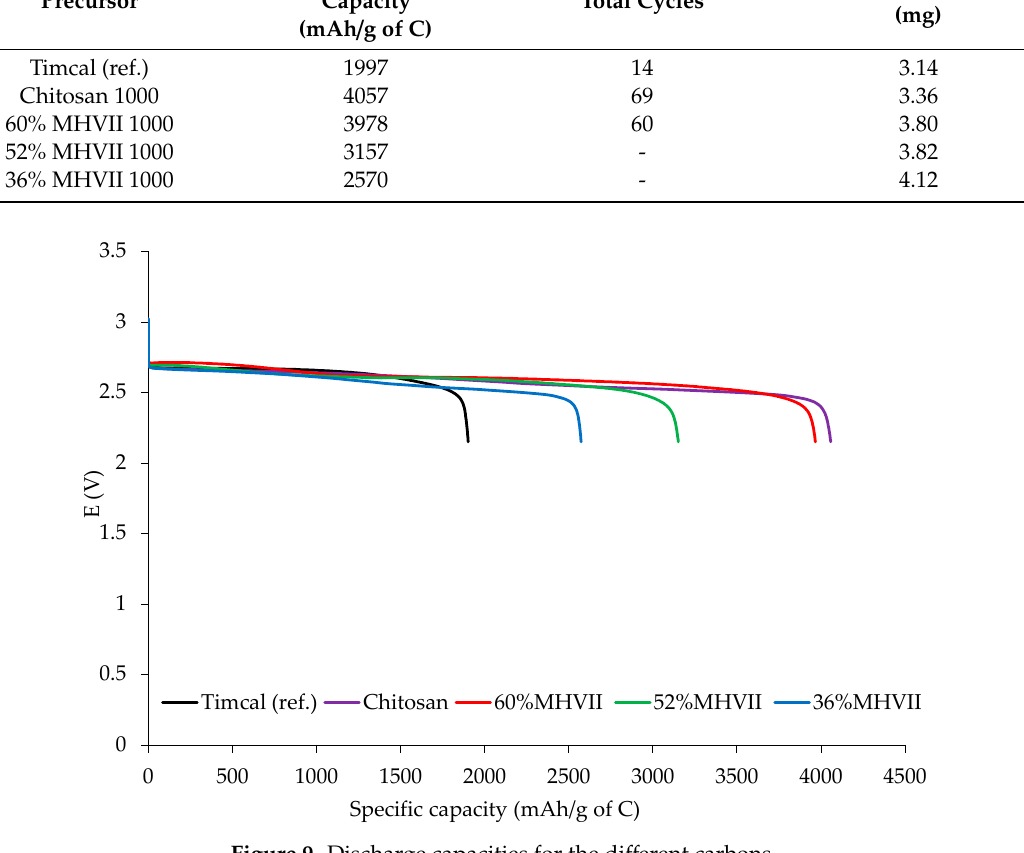
Figure 10. Cycling results for the Li-O 2 batteries with the prepared carbons .